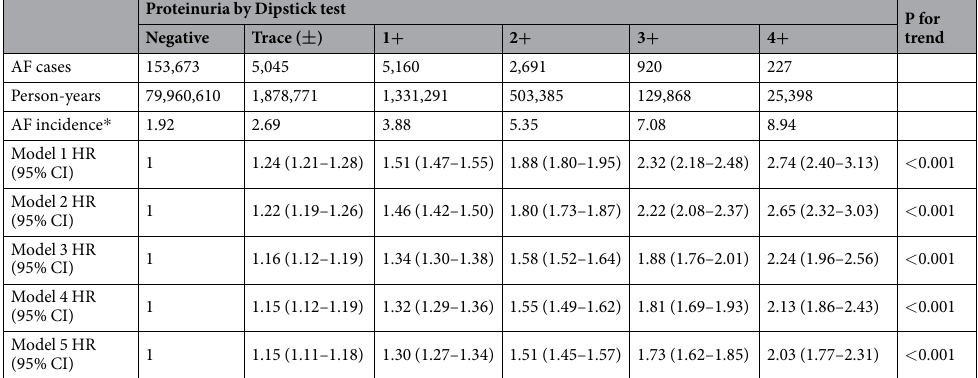
Table 4. Incidence and risk of atrial fibrillation according to the degree of proteinuria by dipstick test adjusted for other covariates in the Follow-up Cohort (between 2009 and 2013). AF, atrial fibrillation; CI, confidence intervals; HR, hazard ratios. * Per 1000 person-years. Model 1 to 4: Cox proportional models as in Table 3. Model 5: model 4 with additional adjustment for estimated glomerular filtration